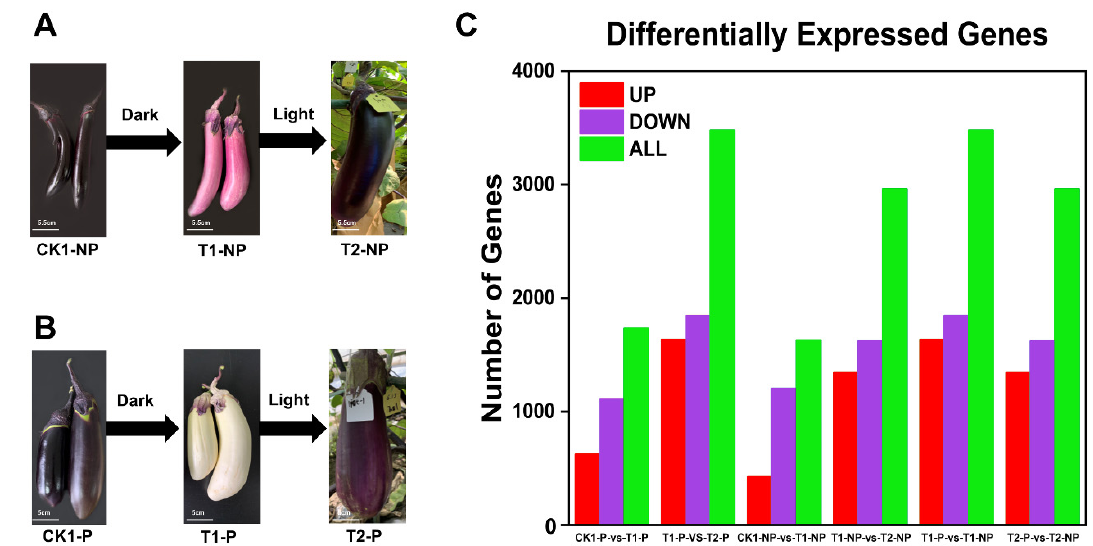
Figure 1. Changes in the appearance and genes of two eggplant varieties after bagging and illumination. ( A ) Changes in the appearance of nonphotosensitive eggplant after shading and illumination; ( B ) changes in the appearance of photosensitive eggplant after shading and illumination; and ( C ) changes in differentially expressed genes in the six comparison groups (both upregulated and downregulated).